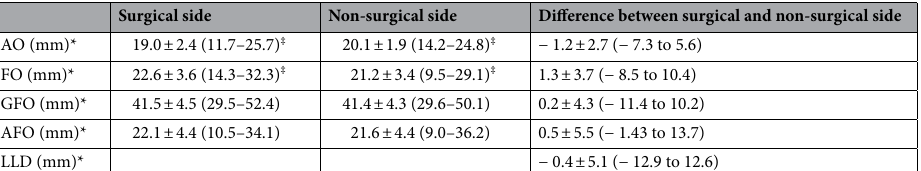
Table 2. Measurement value of pelvic and femoral parameters. Negative values indicated that the length of the surgical side was longer than that of the non-surgical side. AO acetabular offset, FO femoral offset, GFO global femoral offset, AFO anterior femoral offset, LLD leg length discrepancy. *Mean ± standard deviation (range). These values were adjusted to 100 cm of body height. ‡ p < 0.05.